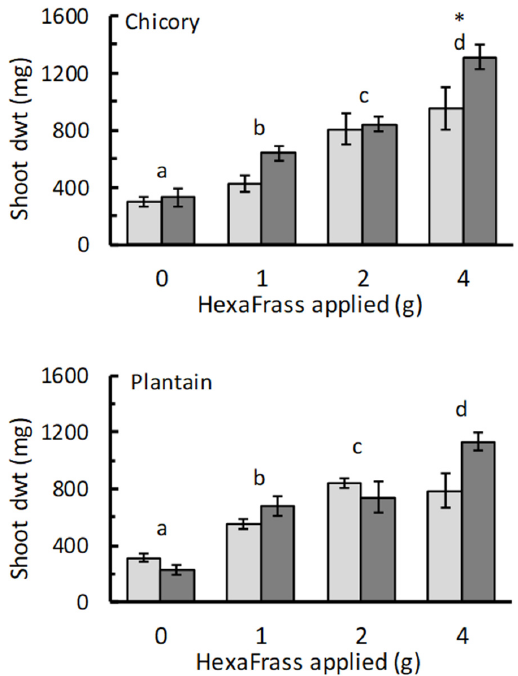
Figure 5. The influence of applying HexaFrass™ (HF) and biochar (light columns 0 g; dark columns 2 g) on the shoot growth (mean ± SE) of chicory and plantain. Pairwise comparison of treatments performed using LSDs at p < 0.05. Letter codes separate HF treatments for each plant. Significant differences between 0 g and 2 g biochar treatments for each HF application rate are indicated by *. For plantain, there was no simple overall effect of adding biochar (F 1,63 = 2.0, p = 0.166), and there were no significant pairwise differences observed within any one HF applica ‐ tion rate (Figure 5). There was also some inconsistency in the effects of adding biochar to plantain, in that biochar caused a slight reduction in growth using the 0 g and 2 g HF